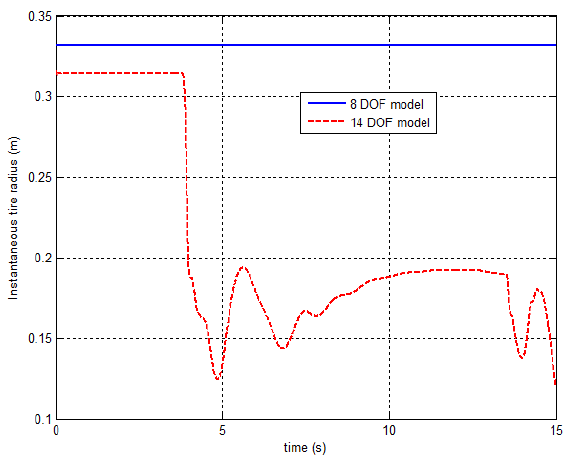
Figure 3. The tyre’s instantaneous radius responses of 8 DOF model and 14 DOF model.